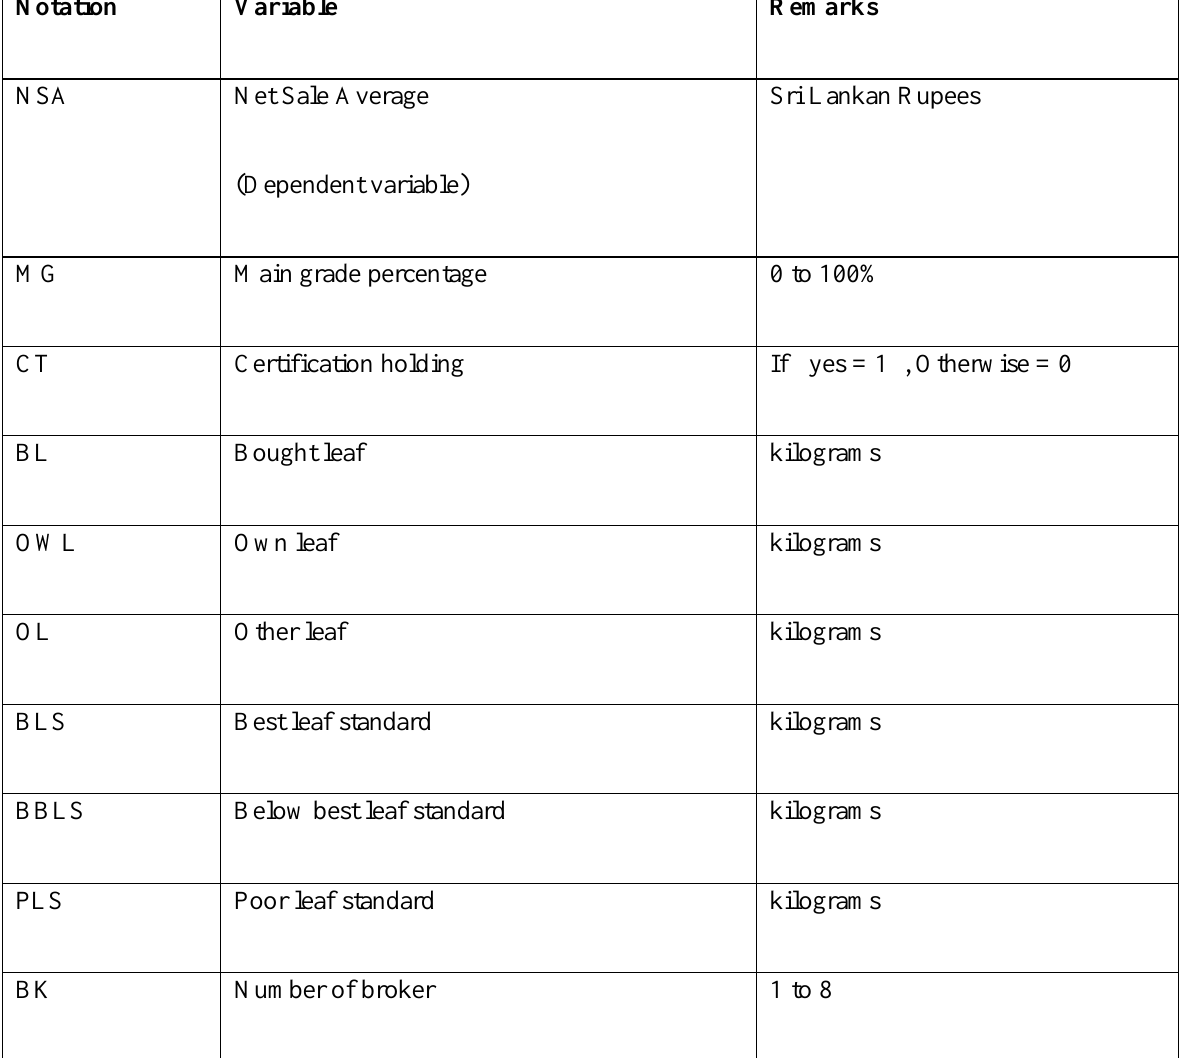
Table 1: Description of Variables for Econometric Model of Tea